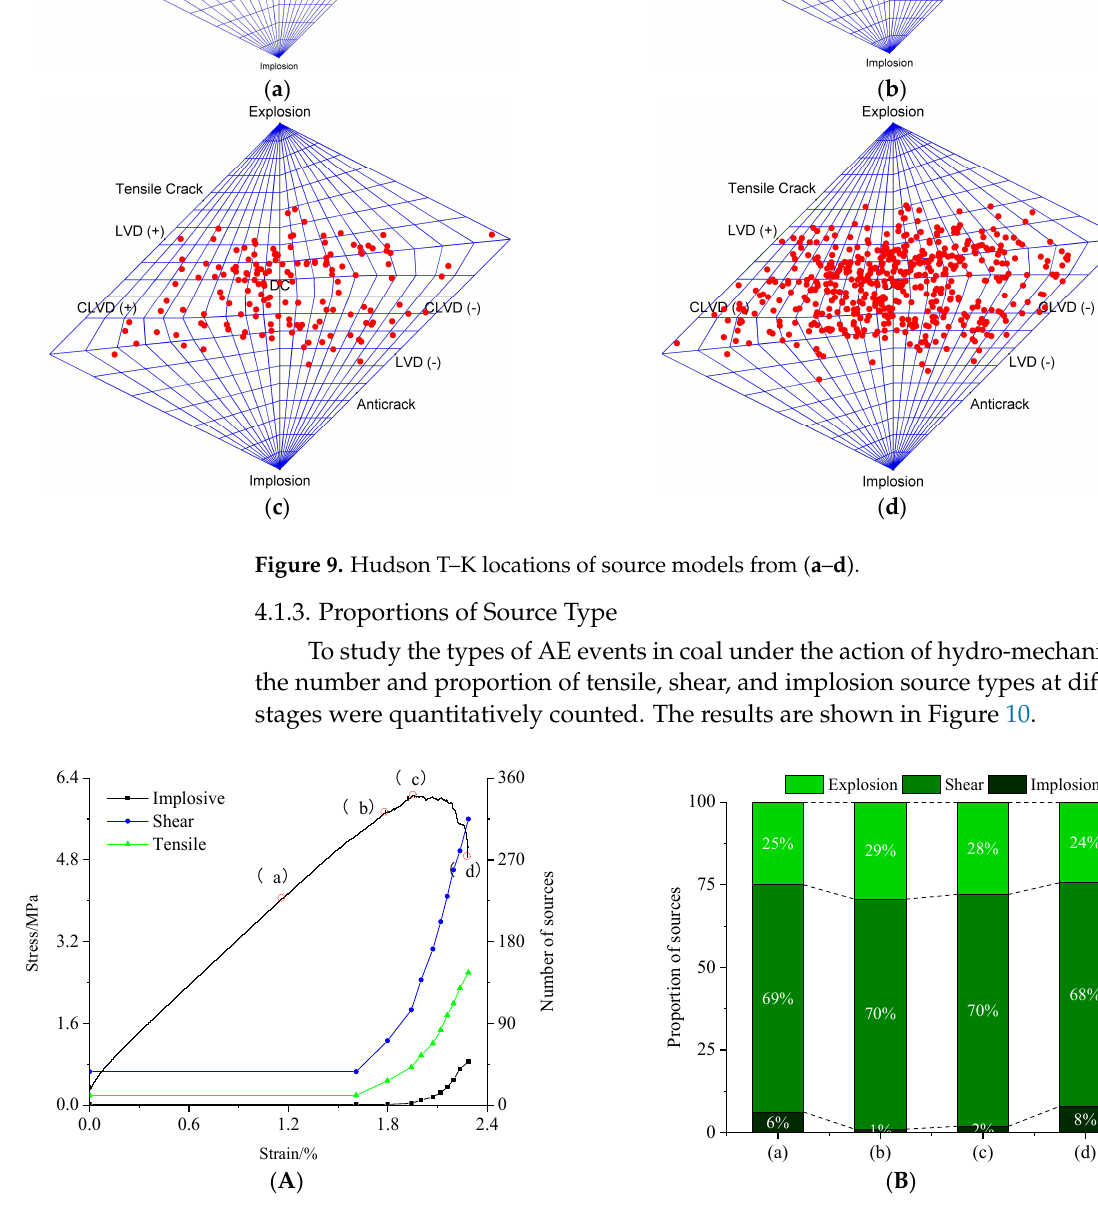
Figure 10. Nature of source versus time in uniaxial compression tests: ( A ) number and ratio of sources and ( B ) proportion of sources. (a–d) are the stages of crack generation, which are pore compaction stage, fracture expansion stage, peak stress stage and post peak stage, respectively. From Figure 10, as the axial stress increases, the numbers of implosions and shears sharply increase; however, their proportions first increase and subsequently decrease. The entire damage is dominated by shear cracks. In stages (a) and (b), the proportions of shear and tension source types become larger, from 69% and 25% to 70% and 29%, respectively. Tensile failure increases in a slightly larger proportion than shear cracks. Observing the AE distribution shows that the damage is mainly concentrated in the lower part of the model. The particles in the water pressure area are subjected to tension. Simultaneously, tensile failure is prone to occur under axial stress. With the increase in the axial stress, the influence of the water pressure gradually weakens. Therefore, in stages (c) and (d), the proportion of tensile source type slightly decreases, whereas that of implosion source type increases to 8%. In summary, the water pressure mainly affects the early stage of loading and is primarily influenced by the axial stress in the later failure process. 4.1.4. Energy Change Coal failure process is accompanied by generation, accumulation, dissipation, and release of energy, and the evolution of energy is closely consistent with the expansion of internal cracks in coal. Using the energy module of the PFC3D, the energy variation was recorded during coal failure process. From Figure 11, the kinetic energy tends to increase in the initial stage of loading. The main cause is the force unbalance between some particles under the action of the axial pressure, which destroys the linear parallel bonds between them. There is no increase in the slip energy within a certain period. When the vertical stress of the coal body reaches approximately 50% peak stress, the kinetic and slip energies gradually increase. When the strain reaches 2%, the model slips overall. At this time, the slip and kinetic energies grad- ually reach maximum. The total strain energy is consistent with the overall change trend of the stress–strain curve.